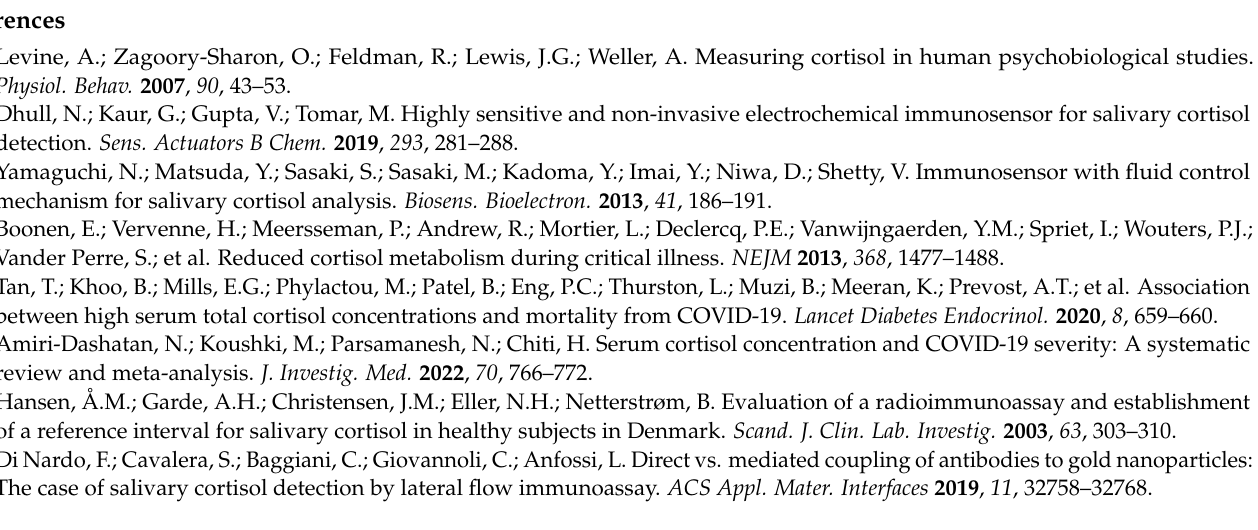
Figure S8: Calibration curve used for HPLC analyses of cortisol. Table S1: Kinetic constants; Table S2: Adsorption isotherm model